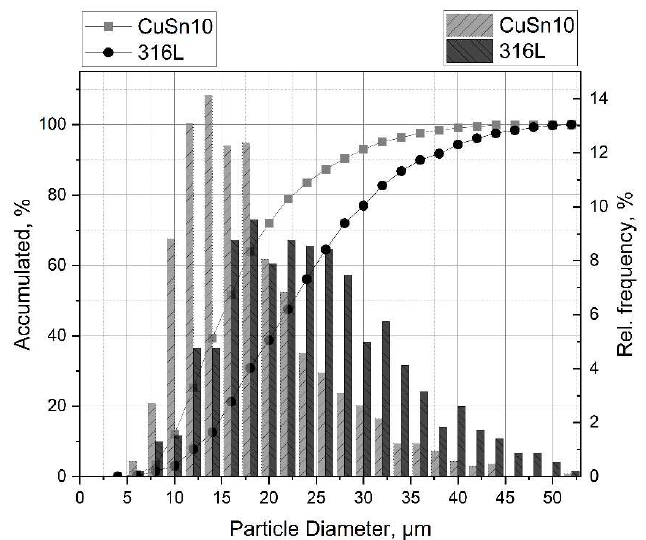
Figure 2. Distribution of powder particle sizes.